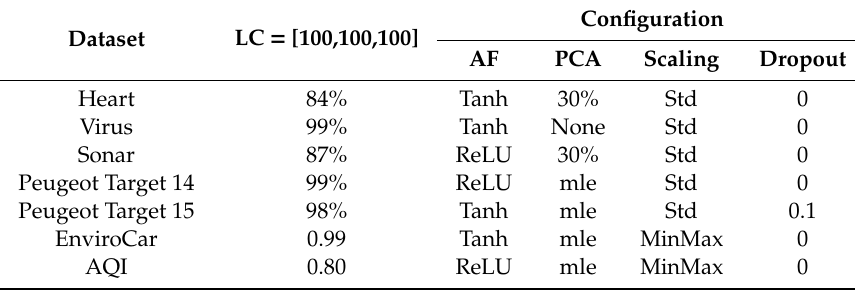
Table 28. Layer configuration LC = [100,100,100] results.